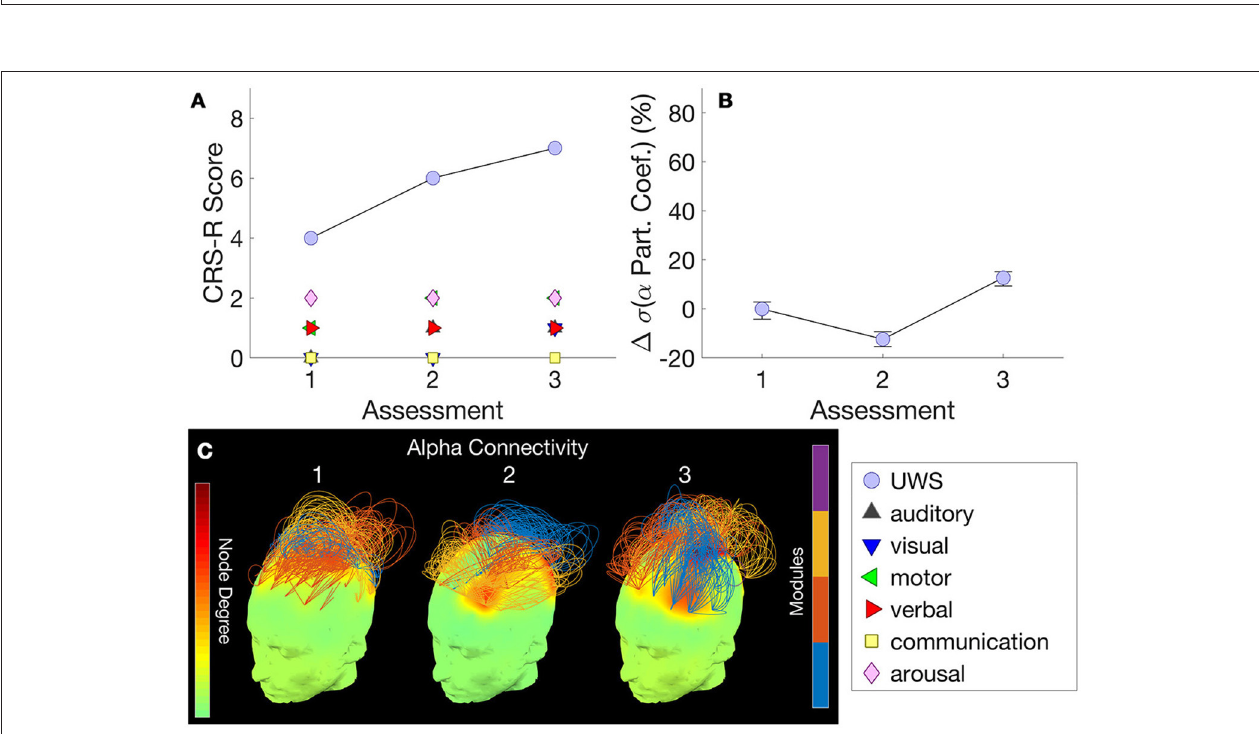
FIGURE 2 | Patient 1 (UWS to MCS-) - CRS-R scores, subscores and diagnosis at each assessment (A) are juxtaposed with the normalized standard deviation of participation coefficients estimated from the patient’s hdEEG alpha band network at each assessment (B) . Consecutive assessments were separated by 3 months. Error bars indicate range of values obtained over 25 repetitions over random subsamples of the original data. (C) visualizes alpha band network topographs at each assessment. In each topograph, the color map over the scalp depicts degrees of nodes in the network (left color scale). Arcs connect pairs of nodes, and their normalized heights indicate the strength of connectivity between them. The color of an arc identifies the module to which it belongs, with groups of arcs in the same color highlighting connectivity within a module (right color scale). Topological modules within the network were identified by the Louvain algorithm ( 16, 18). For visual clarity, of the strongest 30% of connections, only intramodular connections are